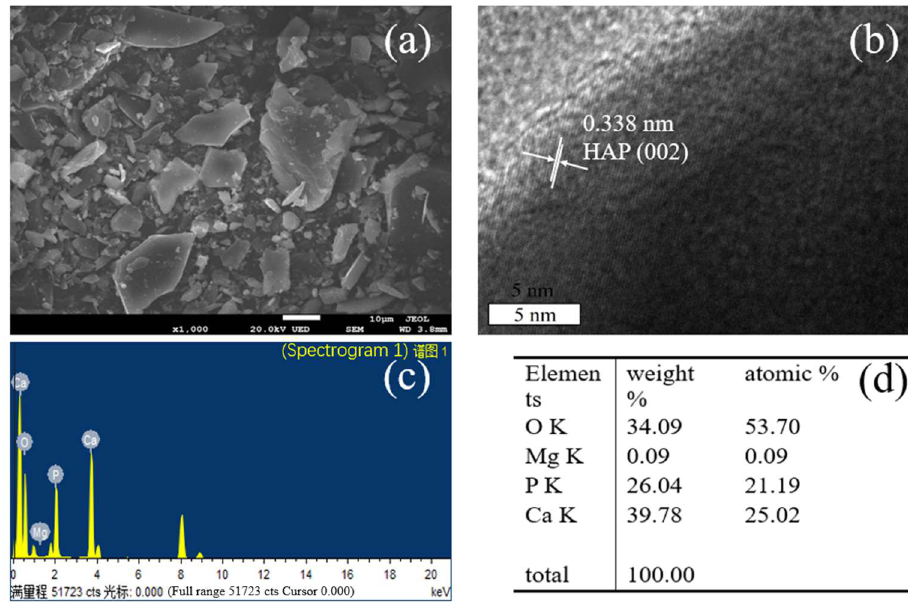
Figure 4. SEM ( a ), TEM ( b ) and EDS ( c , d ) of HAP samples calcined at 800 °C.